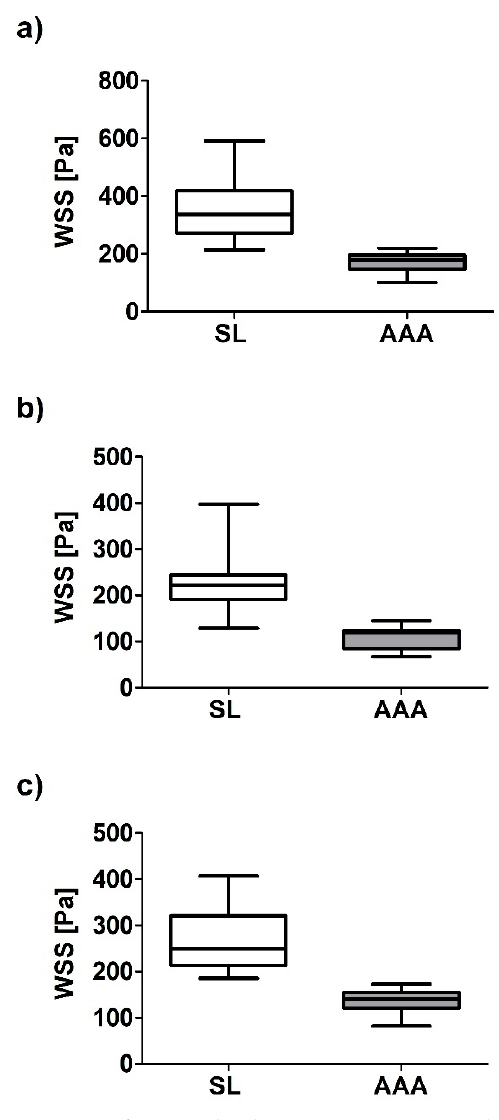
Figure 7. Bar chart representation of WSS value between aneurysm and stent-graft for abdominal aortic aneurysm (AAA) and long stent-graft (SL) for: ( a ) Sharp velocity profile, ( b ) flat velocity profile, ( c ) real velocity profile.